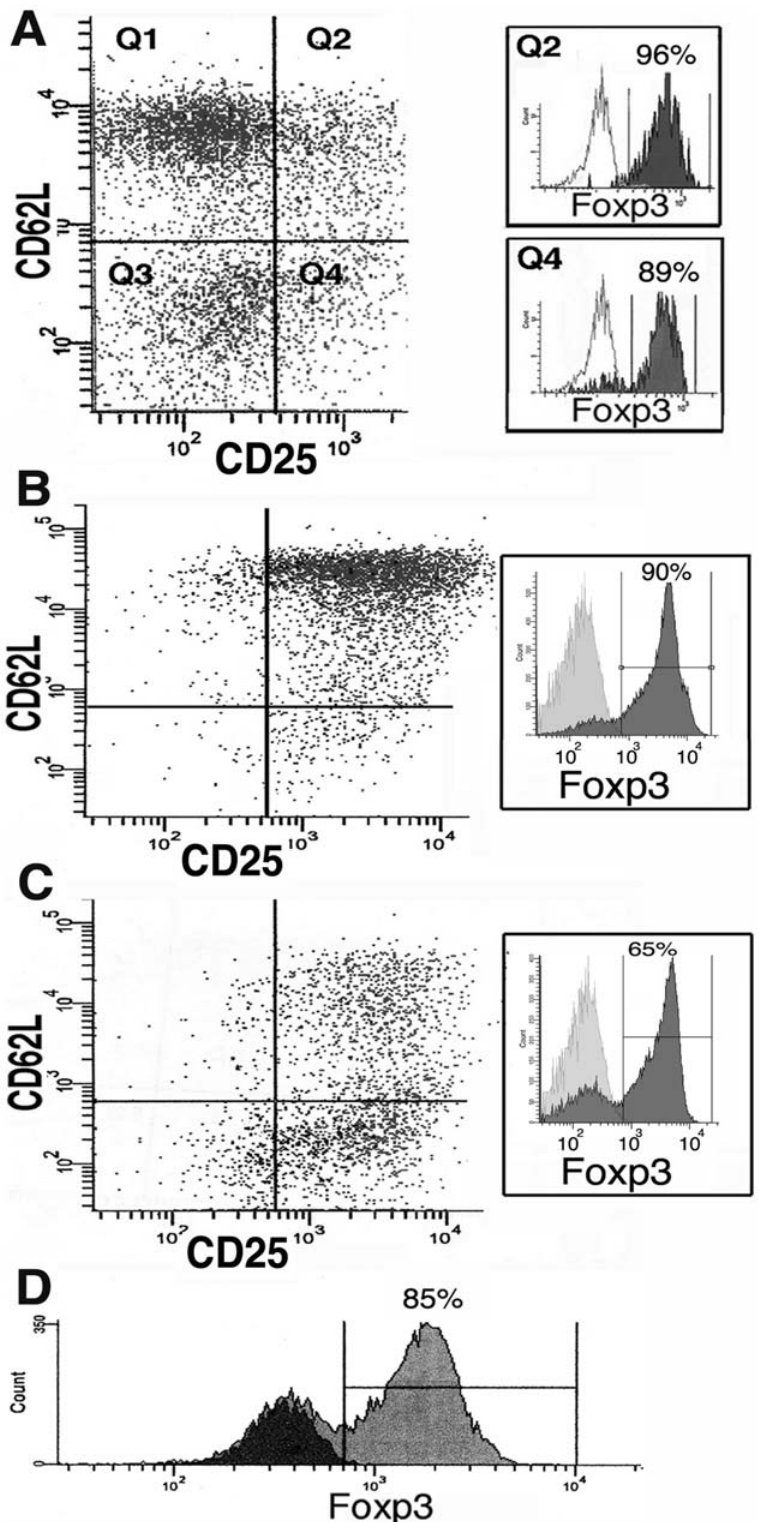
Figure 1. Foxp3 + expression in freshly isolated and expanded CD4 + T reg cells. A) Foxp3 expression in fresh CD25 + CD62L HI cells (Q2, 96%) versus CD25 + CD62L LO cells (Q4, 89%). Isotype control antibody shown for each histogram. B) Expanded Q2 cells demonstrating maintenance of CD62L HI and Foxp3 + expression (90%). C) Expanded Q4 cells demonstrating up-regulation of CD62L HI on 33% of cells and a mixture of 65% Foxp3 + T regs and 35% Foxp3 2 T eff cells post-expansion. D) Foxp3 + expression (grey histogram, 85% of cells) following expansion of the entire CD4 + CD25 + T cell subset. Isotype control shown in black histogram. doi:10.1371/journal.pone.0006031.g001 PLoS ONE |